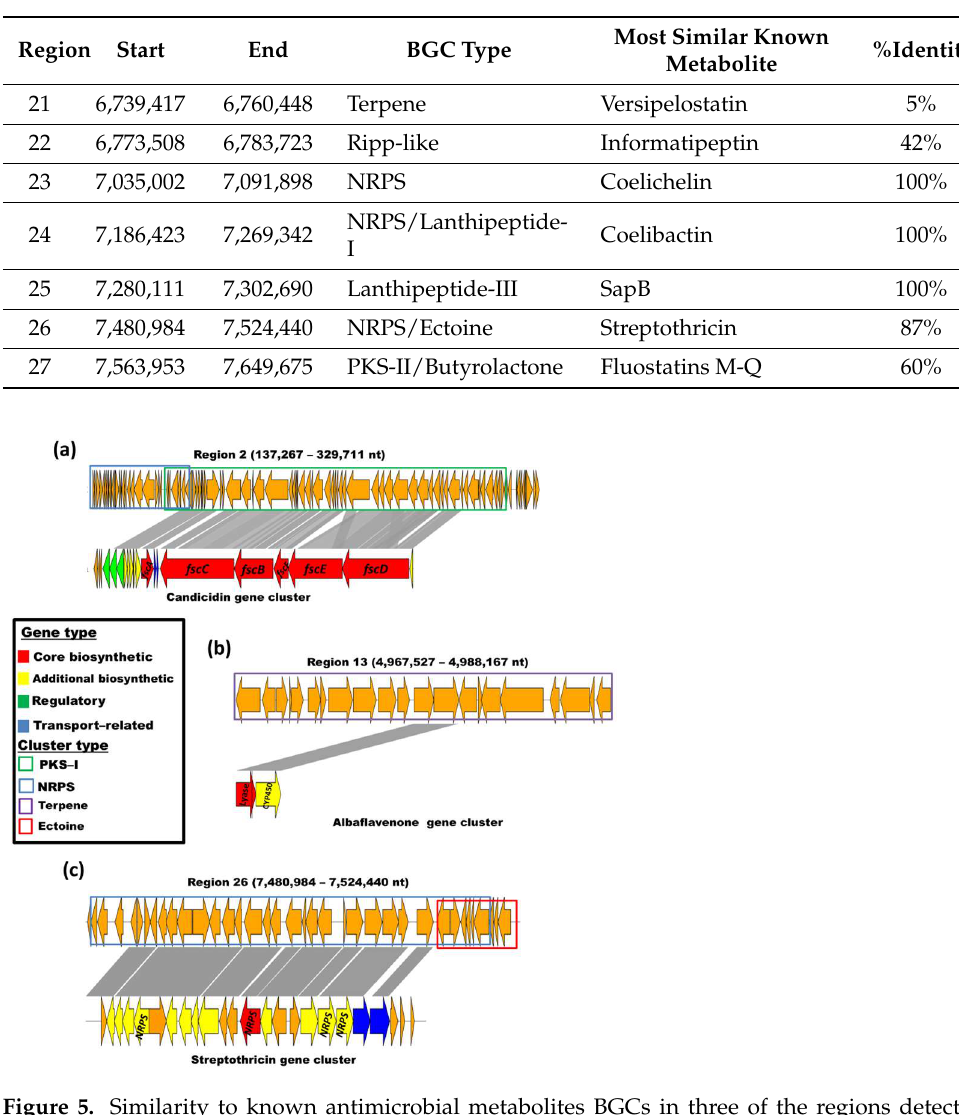
Figure 5. Similarity to known antimicrobial metabolites BGCs in three of the regions detected with AntiSMASH in the genome of Streptomyces vinaceusdrappus strain AC-40: ( a ) candicidin; ( b ) albaflavenone; ( c ) streptothricin. The characteristics of the clusters and gene types are indicated in the